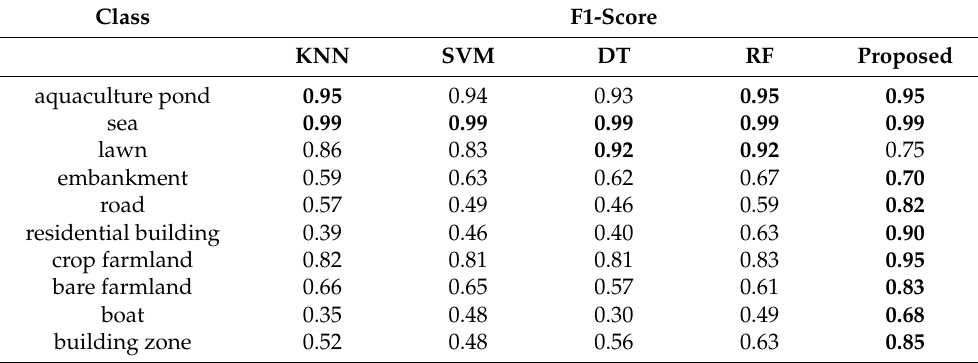
Table 5. Comparison of F1 scores using the KNN, SVM, DT, RF, and proposed methods for experi- mental scene B. Bold represents the highest precision of a same class among these